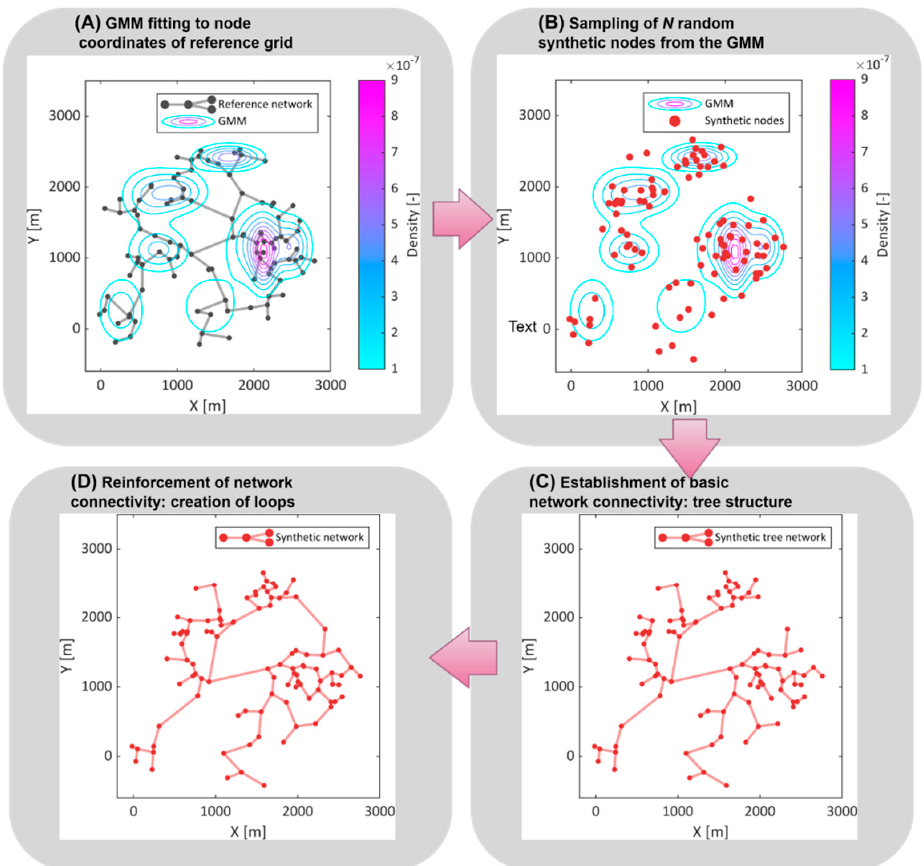
Figure 1. Example of synthetic network topology generation: a Gaussian Mixture Model is fitted to the node coordinates of the reference grid ( A ) and subsequently used to generate N points constituting the nodes of the synthetic network ( B ); the nodes are linked together in a tree-shaped network structure ( C ), which is finally assigned with additional connections forming loops ( D ).